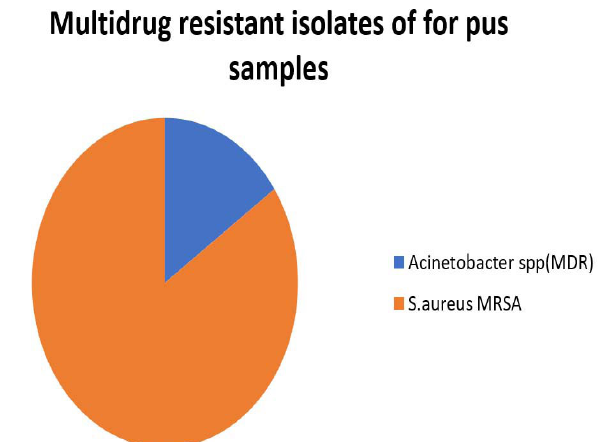
Fig. 12. Multidrug-resistant isolates of the pus samples